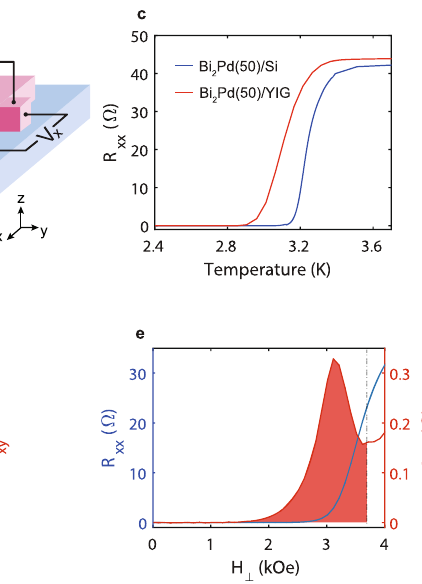
Fig. 1 | The physical properties of β - Bi 2 Pd fi lm. a Crystal structure of super- conductor β - Bi 2 Pd. b Experimental setup. The d.c. current was applied in the fi lm plane along the x-axis. Voltage along x- and y-axis were recorded simultaneously. The longitudinal ( R xx ) and transverse resistance ( R xy ) were derived accordingly. c R xx asafunctionoftemperaturefor50nm β - Bi 2 Pd fi lmswhichweredepositedon